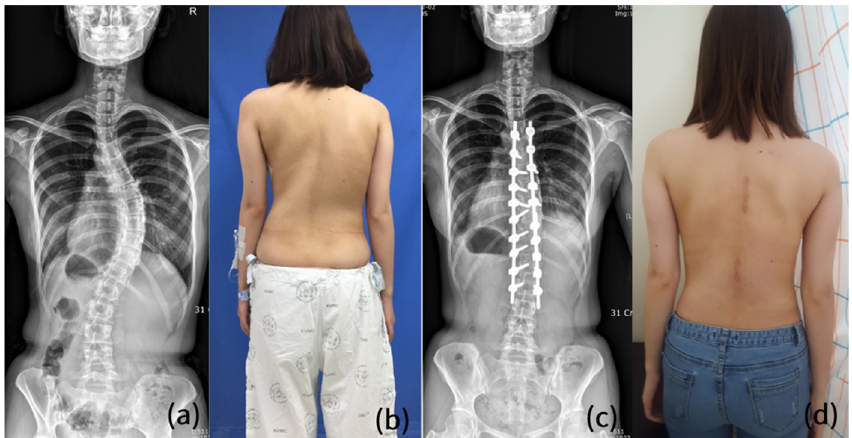
Figure 5. A 16-year-old female AIS patient who underwent MISS with two skin incisions. ( a , b ) An AIS patient with Lenke type 1 curve and Risser’s stage 5. ( c , d ) The postoperative whole spine anteroposterior plain radiograph and clinical photo showing satisfactory coronal balance. AIS, adolescent idiopathic scoliosis; MISS, minimally invasive scoliosis surgery.